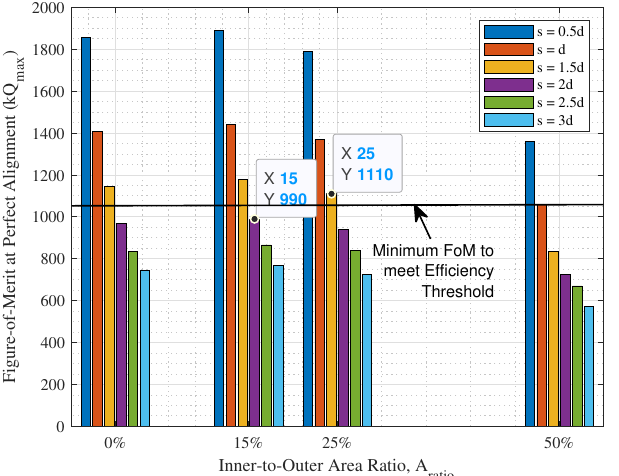
Figure 7. FoM at perfect alignment for different A ratio using different turn-to-turn spacing, s .